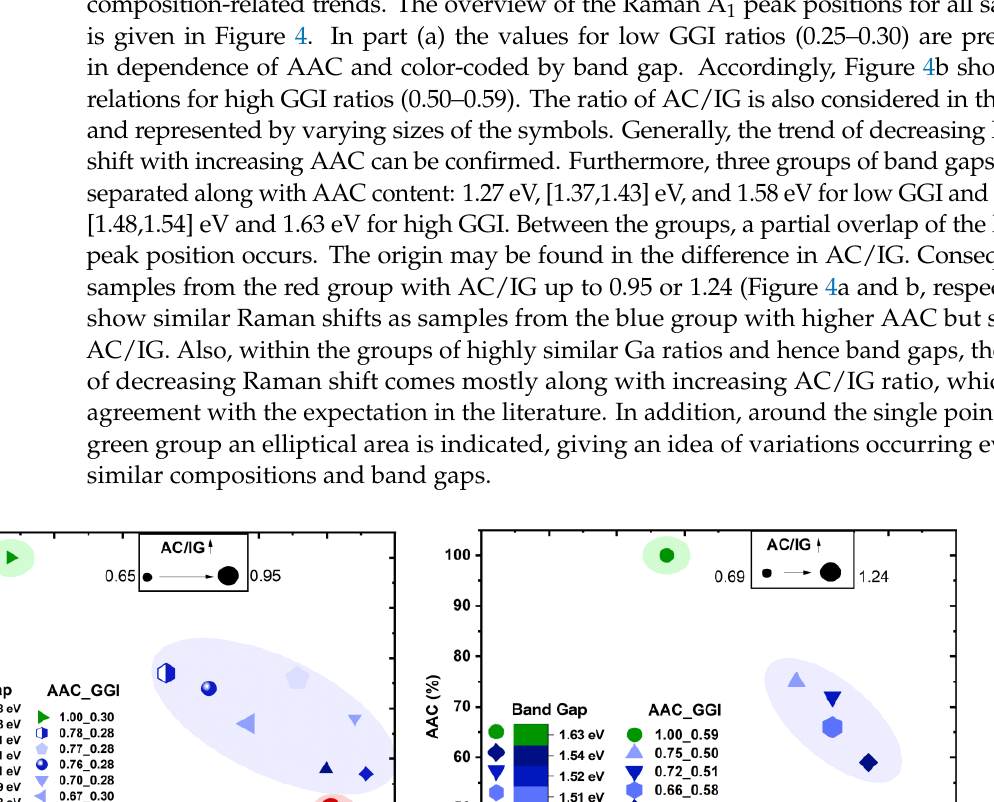
( b ) Figure 5. ( a ) Spatial distribution of Raman-shift for exemplary ACIGSe sample; ( b ) Individual Ra- man spectra integrated within the given wavenumber range to obtain the map in ( a ).